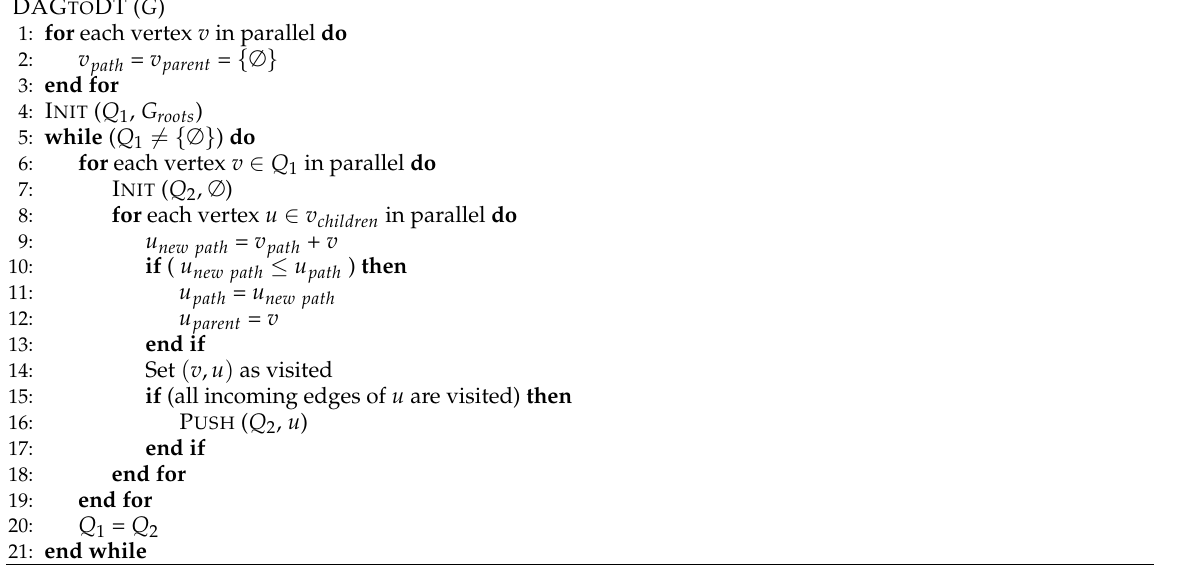
Algorithm 3 Step 1: From DAG to DT with a top-down BFS.